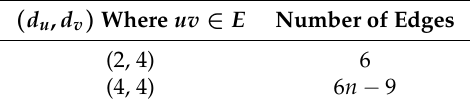
Table 6. Edge partition of G n ( n